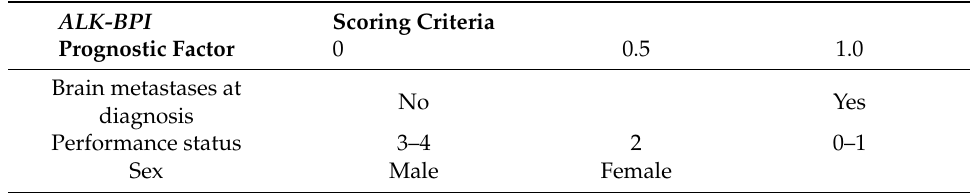
Table 2. ALK-BPI, DS-GPA and Lung-molGPA